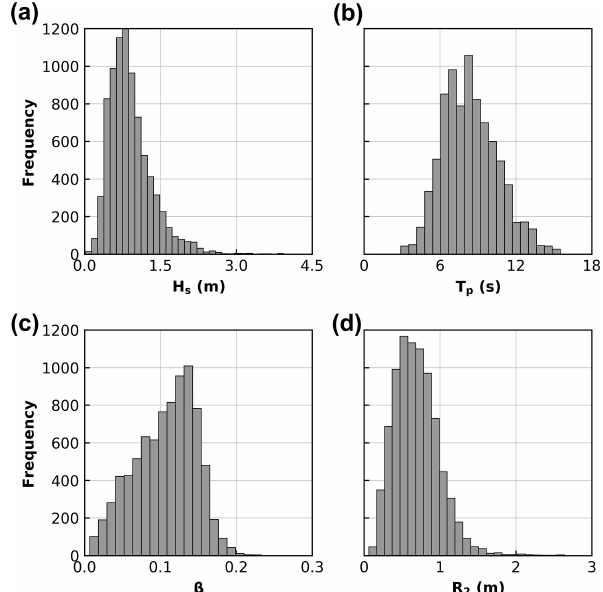
Figure 3. Histograms of the 8328 data samples extracted from the Narrabeen lidar: (a) significant wave height ( H s ); (b) peak wave period ( T p ); (c) beach slope ( β ); and (d) 2% wave runup eleva- tion ( R 2